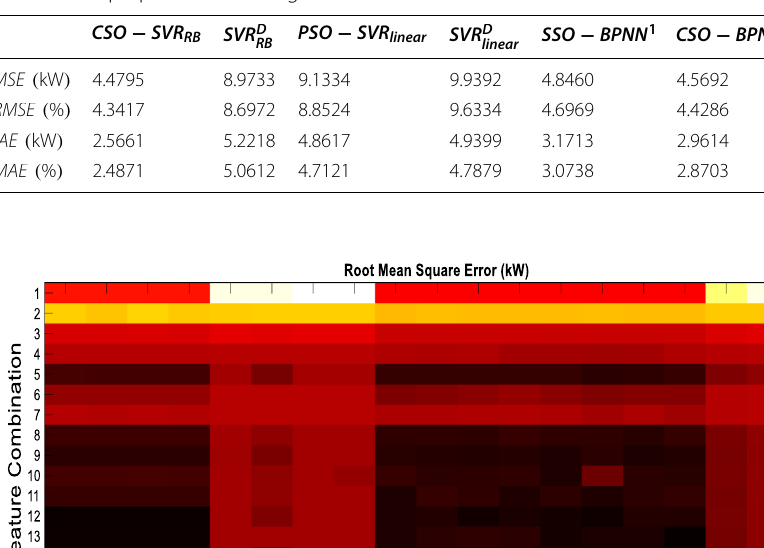
Table 5 Best proposed forecasting models vs. default models based on SVR and ANN